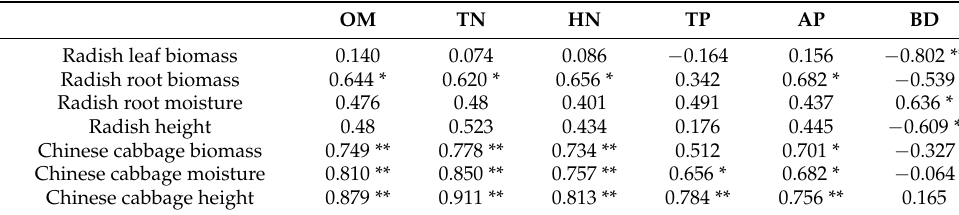
Table 13. Pearson correlation between the nutritive elements and plant